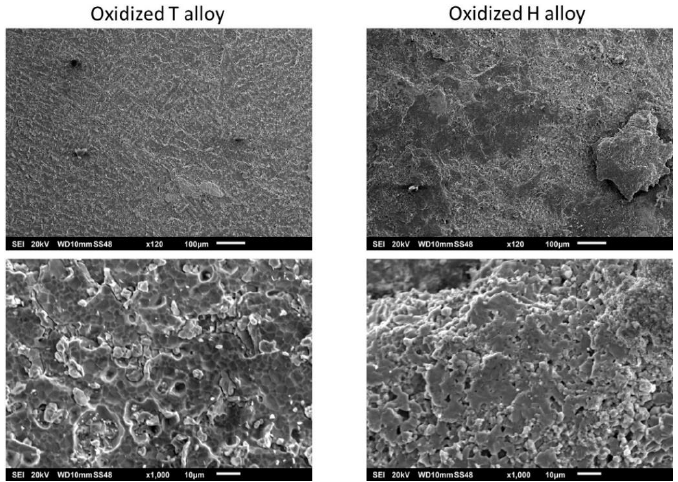
Figure 9. Aspects of the oxidized surfaces of the two alloys ( left : T alloy, right : H alloy, top : general view, bottom : detailed view).